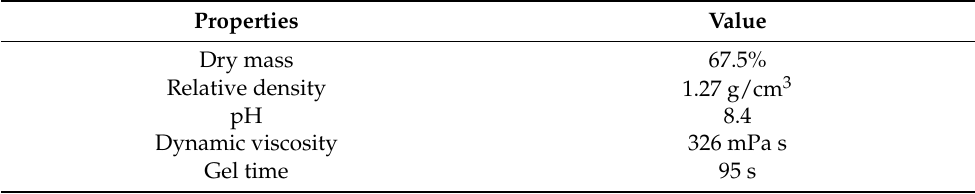
Table 1. Properties of MUF